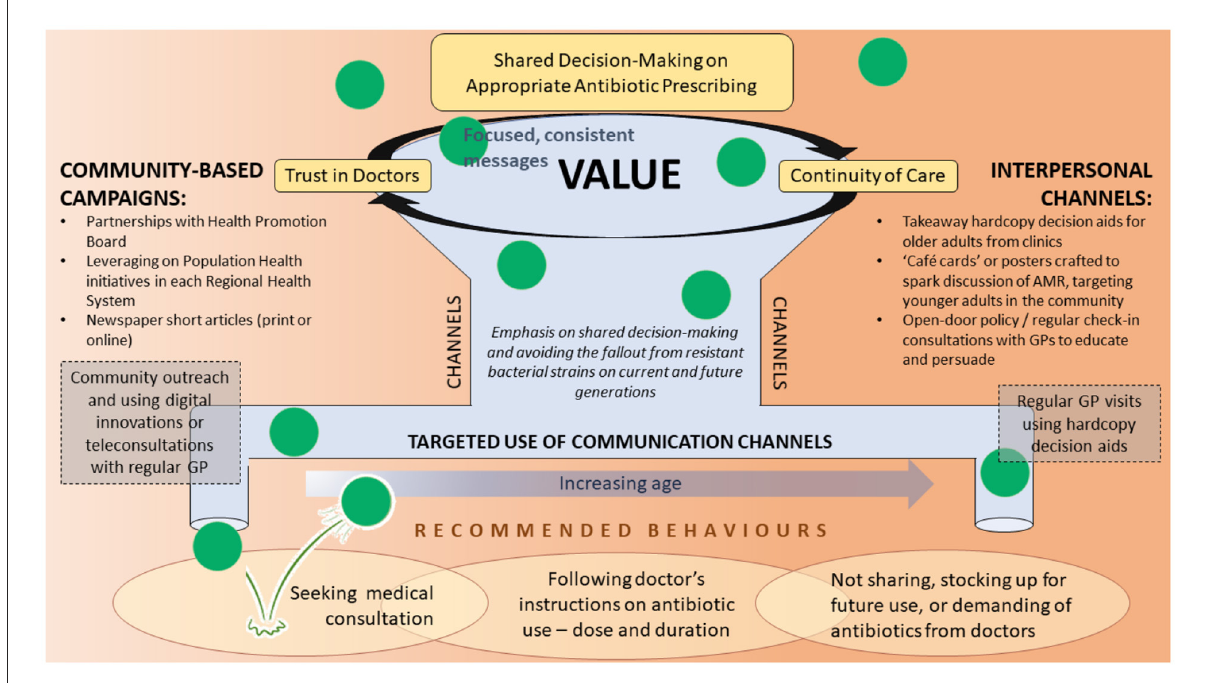
FIGURE4 A strategic implementation model to guide the designing of interventions to improve appropriate antibiotic use in the general